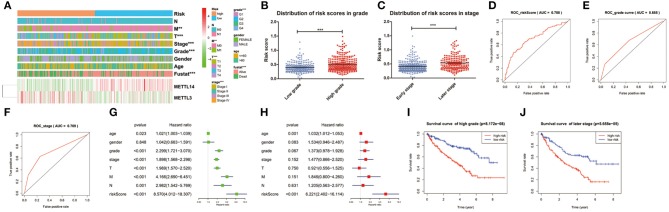
Relation between the risk score and clinicopathological characteristics, as well as prognostic value of the risk signature in patients stratified by WHO grade and pathological stage. (A) The heatmap shows the expression of the 2 m6A RNA methylation regulators in high-risk and low-risk ccRCC. The distribution of clinicopathological characteristics was compared between the high-risk and low-risk groups. *p < 0.05, **p < 0.01 and ***p < 0.001. (B,C) The distribution of risk score in patients stratified by WHO grade and pathological stage. *p < 0.05, **p < 0.01, and ***p < 0.001. (D–F) ROC curves showed the predictive efficiency of the risk score (D), WHO grade (E), and pathological stage (F). (G) Univariate Cox regression analysis of the associated between clinicopathological factors (including risk score) and overall survival of patients. (H) Multivariate Cox regression analysis of the associated between clinicopathological factors (including risk score) and overall survival of patients. (I) Kaplan-Meier overall survival curve for patients with low grade and high grade. (J) Kaplan-Meier overall survival curve for patients with early grade and later pathological stage.